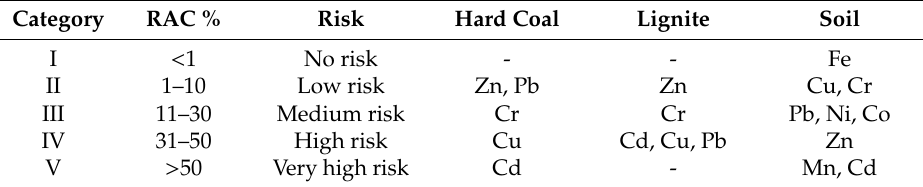
Table 5. Risk assessment category and classification of risk assessment code (RAC) values for elements [40,41] and environmental risk of PTEs leaching from investigated dusts and upper horizons of soil samples. Category